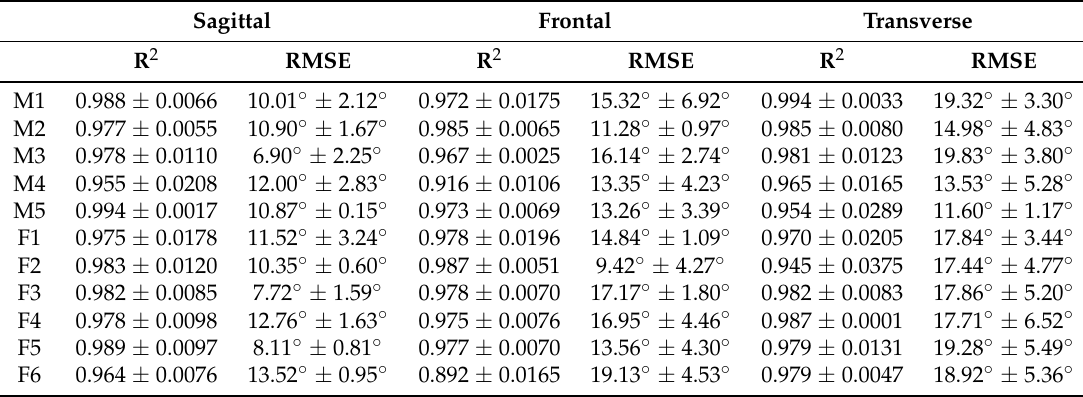
Table 4. RMSE and correlation coefficient for Cameras and